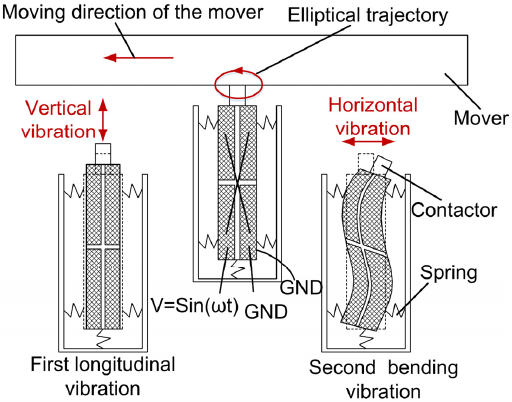
Figure 3. Working principle of the multilayer piezoelectric actuator.